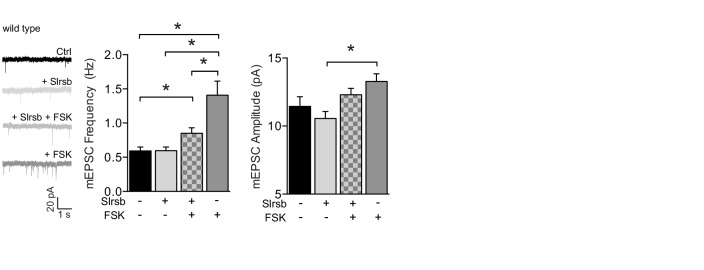
Farnesyltransferase antagonist Salirasib, a non-selective Ras inhibitor, partly blocks cAMP-driven synaptic potentiation.Example traces, mEPSC frequencies and mEPSC amplitudes of untreated CA1 neurons (n=19), neurons incubated with forskolin (n=14), with Salirasib (n=18), preincubated with salirasib prior to forskolin (n=14). Salirasib partially blocked the forskolin-mediated increase in mEPSC frequency (ANOVA, ctrl vs Slrsb: p>0.9; ctrl vs Slrsb: p=0.04; ctrl vs FSK: p<0.0001; FSK vs Slrsb/FSK: p=0.04). Error bars indicate SEM, * indicates p<0.05.